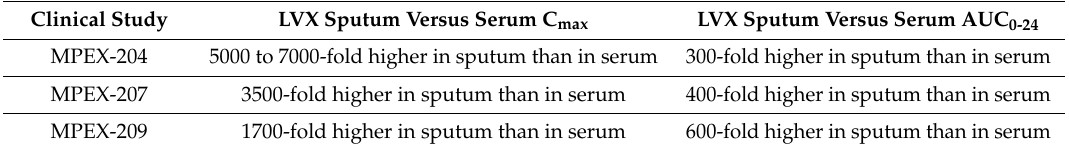
Table 3. Estimates of LVX C max and AUC 0-24 in sputum of CF patients expressed as a number of times those were calculated in the serum obtained from the phase 2 and phase 3 clinical